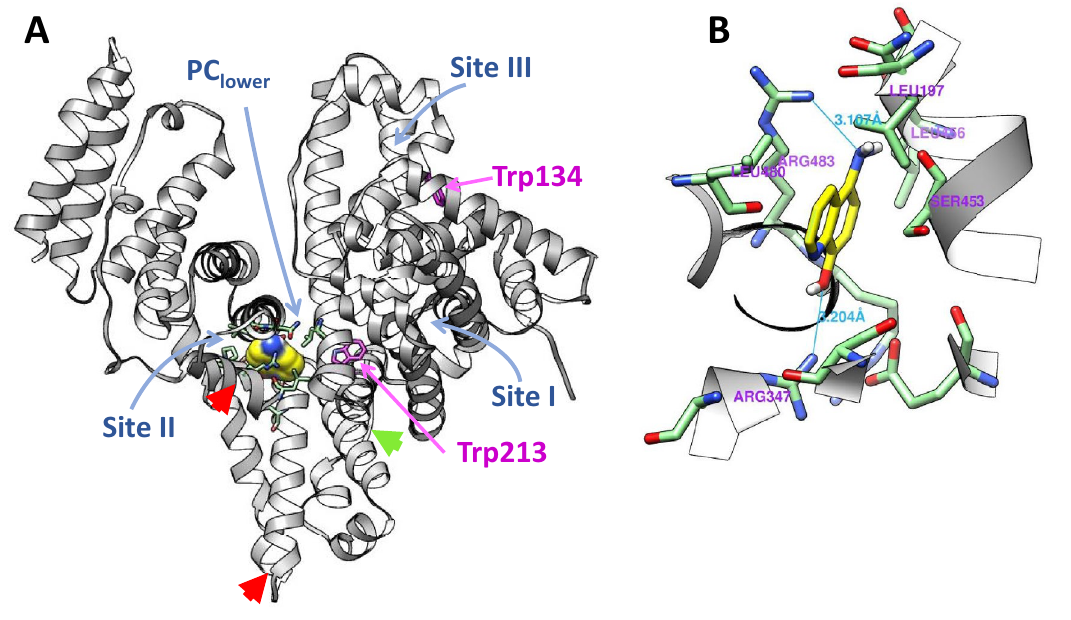
Figure 9. ( A ) Ribbon representation of BSA structure and superimposition of 5A8HQ (yellow surface contour) at the most favorable binding site. Major distortions of structural flexibility are marked by arrowheads. Red arrowheads indicate the decreased fluctuation regions, while green arrowhead refers the increased fluctuation region of BSA upon interaction with 5A8HQ. ( B ) Interaction network among 5A8HQ and amino acid residues of BSA within 5 Å radius. Hydrogen bonds and estimated distances are shown in cyan